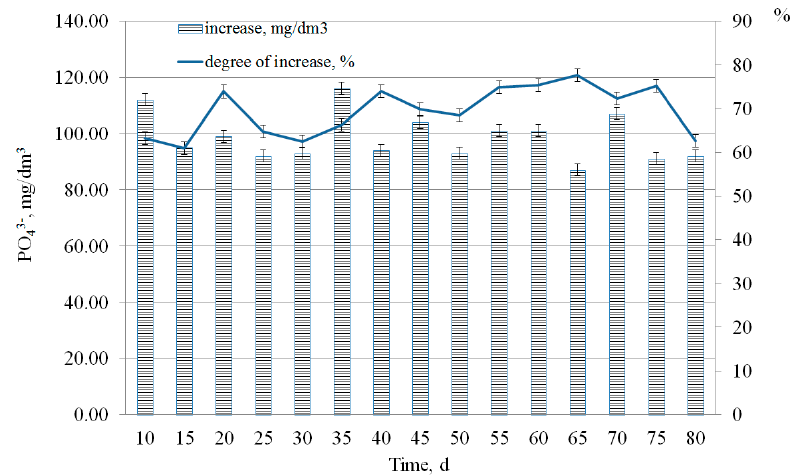
Figure 10. Increase in the concentration of phosphate in the liquid phase after treatment under sulphate-reducing conditions with phosphogypsum.